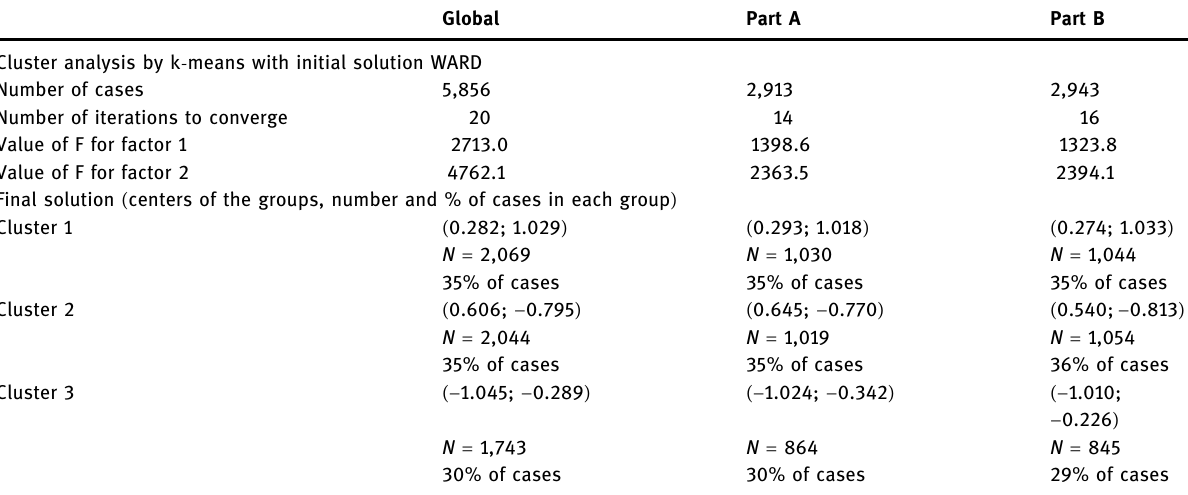
Table 9: Evaluation of the stability of the solution obtained by cluster analysis Global Part